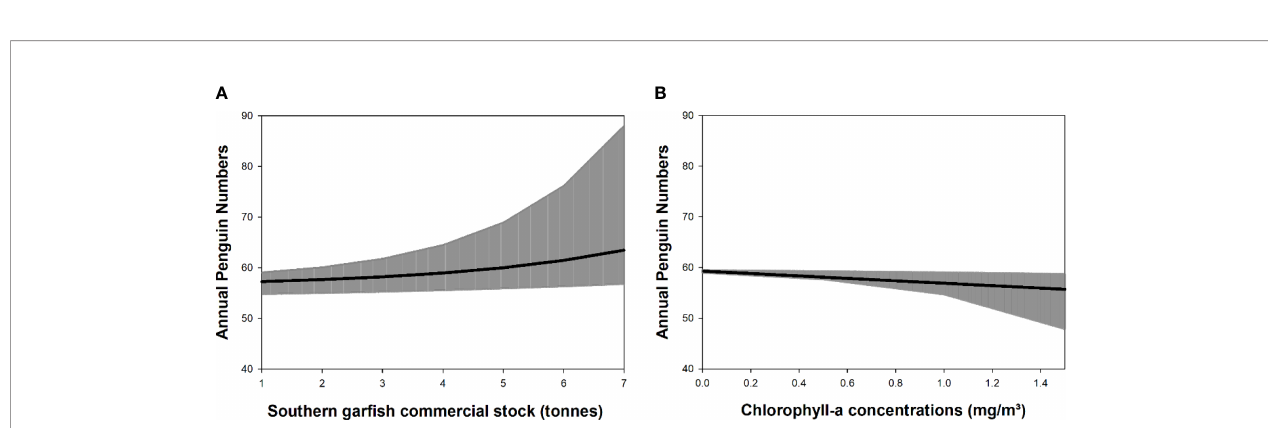
FIGURE 6 | Relationship between the annual little penguin numbers on Granite Island (South Australia) and (A) southern gar fi sh commercial catch numbers (tonnes) or (B) chlorophyll-a concentrations (mg/m³). Each plot represents the effect of a single predictor on the annual number of little penguins assuming all other predictors remain constant. The slope of the relationship is represented by the black line; shaded areas indicate 95% con fi dence